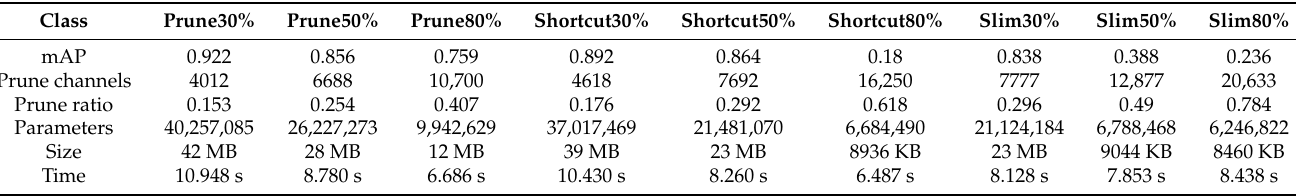
Table 5. Performance using sparse training Method A on